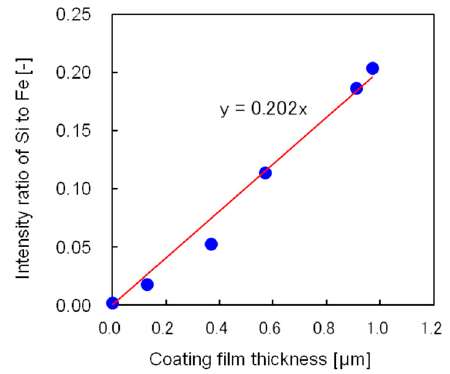
Figure 9. Relationship between the silicon-to-iron X-ray fluorescence intensity ratio and coating film thickness measured from the cross-sectional scanning electron micrograph.